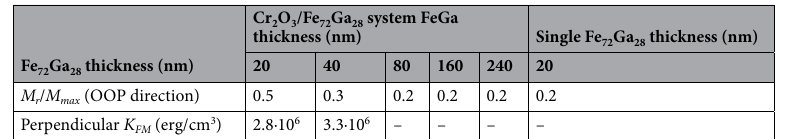
Table 1. OOP squareness ( M r / M max ) calculated from the perpendicular hysteresis loops as a function of the Fe 72 Ga 28 thickness in the Cr 2 O 3 /Fe 72 Ga 28 system, and for an uncoupled single Fe 72 Ga 28 layer. Perpendicular magnetic anisotropy (K FM ) for the Cr 2 O 3 /Fe 72 Ga 28 system in those samples in which the OOP direction is a clear easy axis.